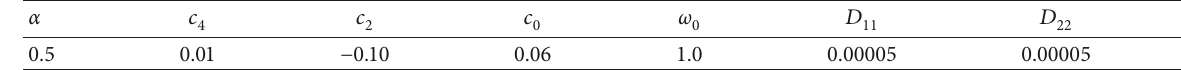
Figure 4: Section graphs of joint probability density function s when x Table 4: Parameter values used in simulation.